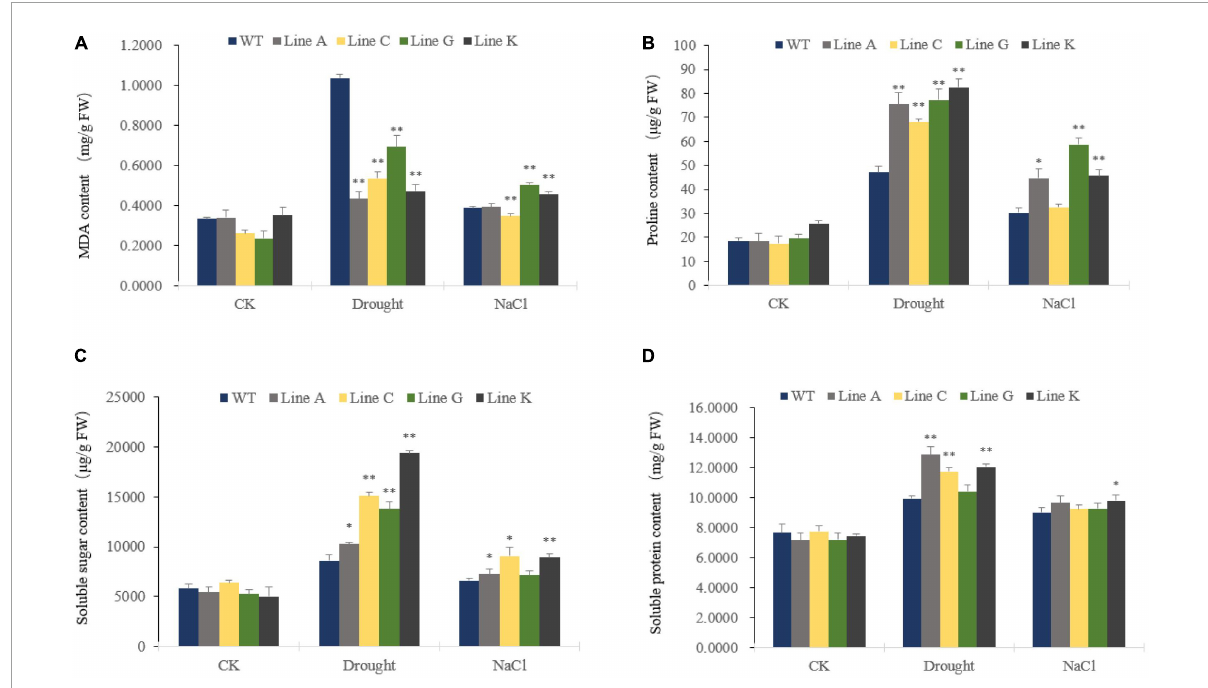
FIGURE5 Analysis of membrane lipid peroxidation products and osmotic regulation substances under different stress treatments. Malondialdehyde (MDA) (A) , Proline (Pro) (B) , Soluble sugar (C) , and Soluble protein (D) contents were measured for transgenic and WT plants. Data are presented as mean and SD values of three independent experiments. Asterisks indicated significant difference ( ∗ P < 0.05, ∗∗ P < 0.01, by Student’s t -test) comparing to